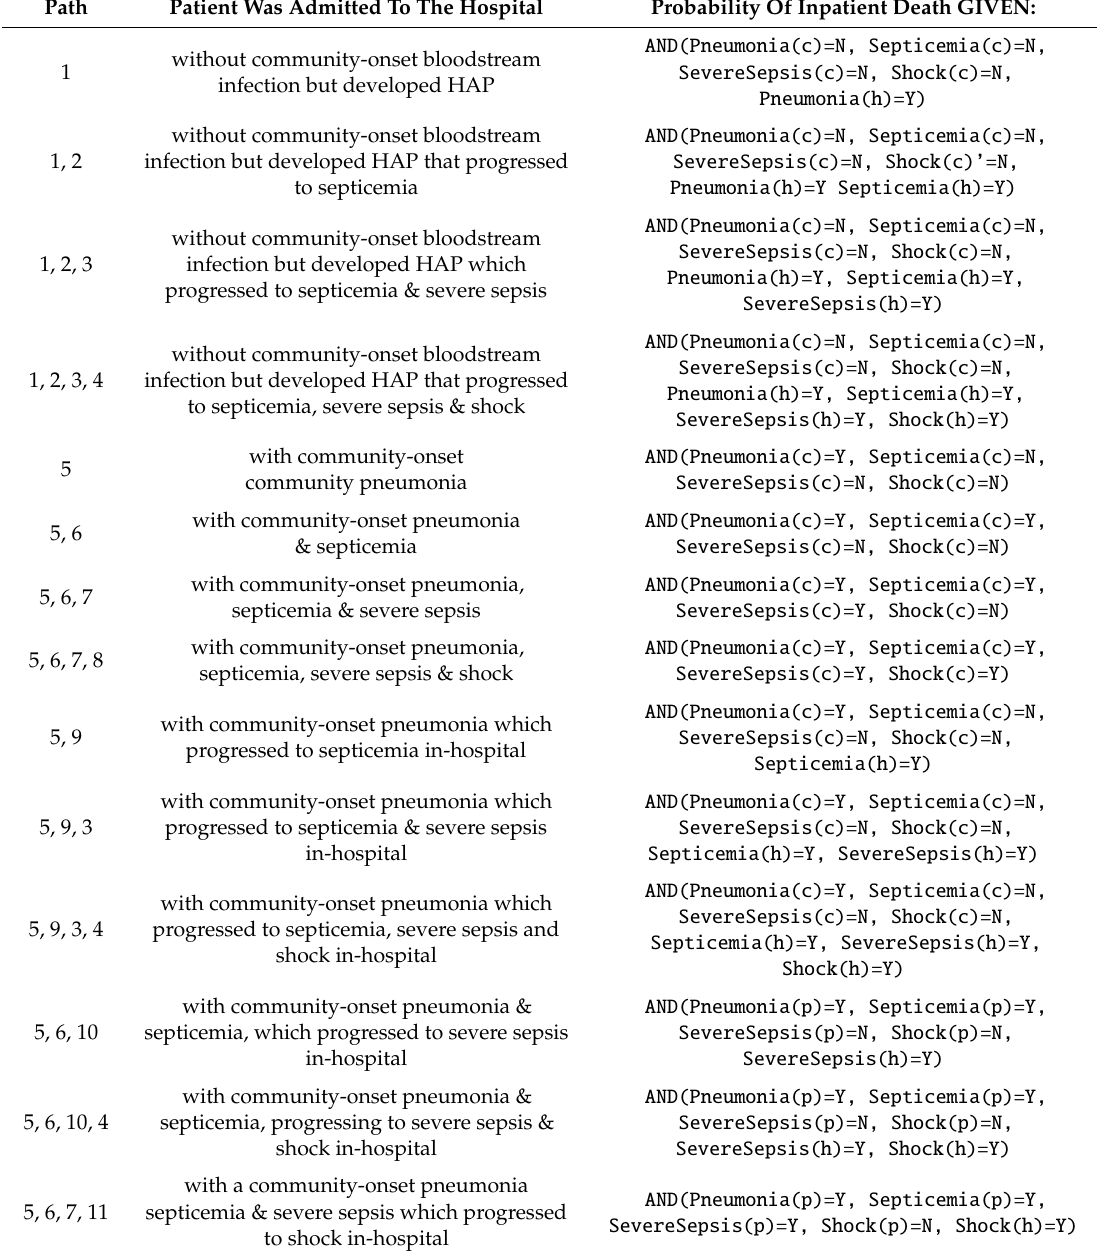
Table 2. Paths of pneumonia-induced bloodstream